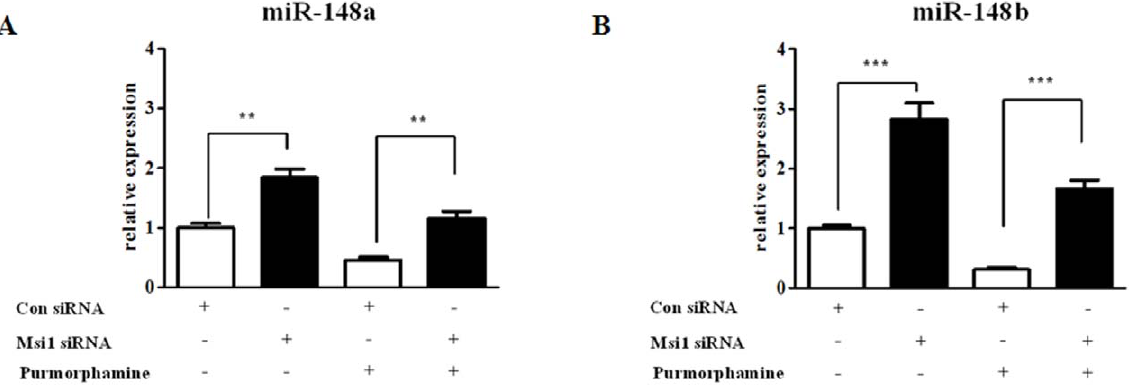
Figure 8. The effects of purmorphamine on miR-148a and miR-148b are mediated through Msi1. hUCB-MSCs were first transfected with 50 nM Msi1 siRNA for 48 h and then treated with or without 4 m M purmorphamine for 3 days. The expression profiles of the miRNAs were then analyzed using real-time PCR. Purmorphamine treatment attenuated the stimulatory effects of Msi1 knockdown on miR-148a ( A ) and miR-148b ( B ) expression. The results are shown as the mean 6 SD from three independent experiments. * P , 0.05, ** P , 0.01, and *** P , 0.001.